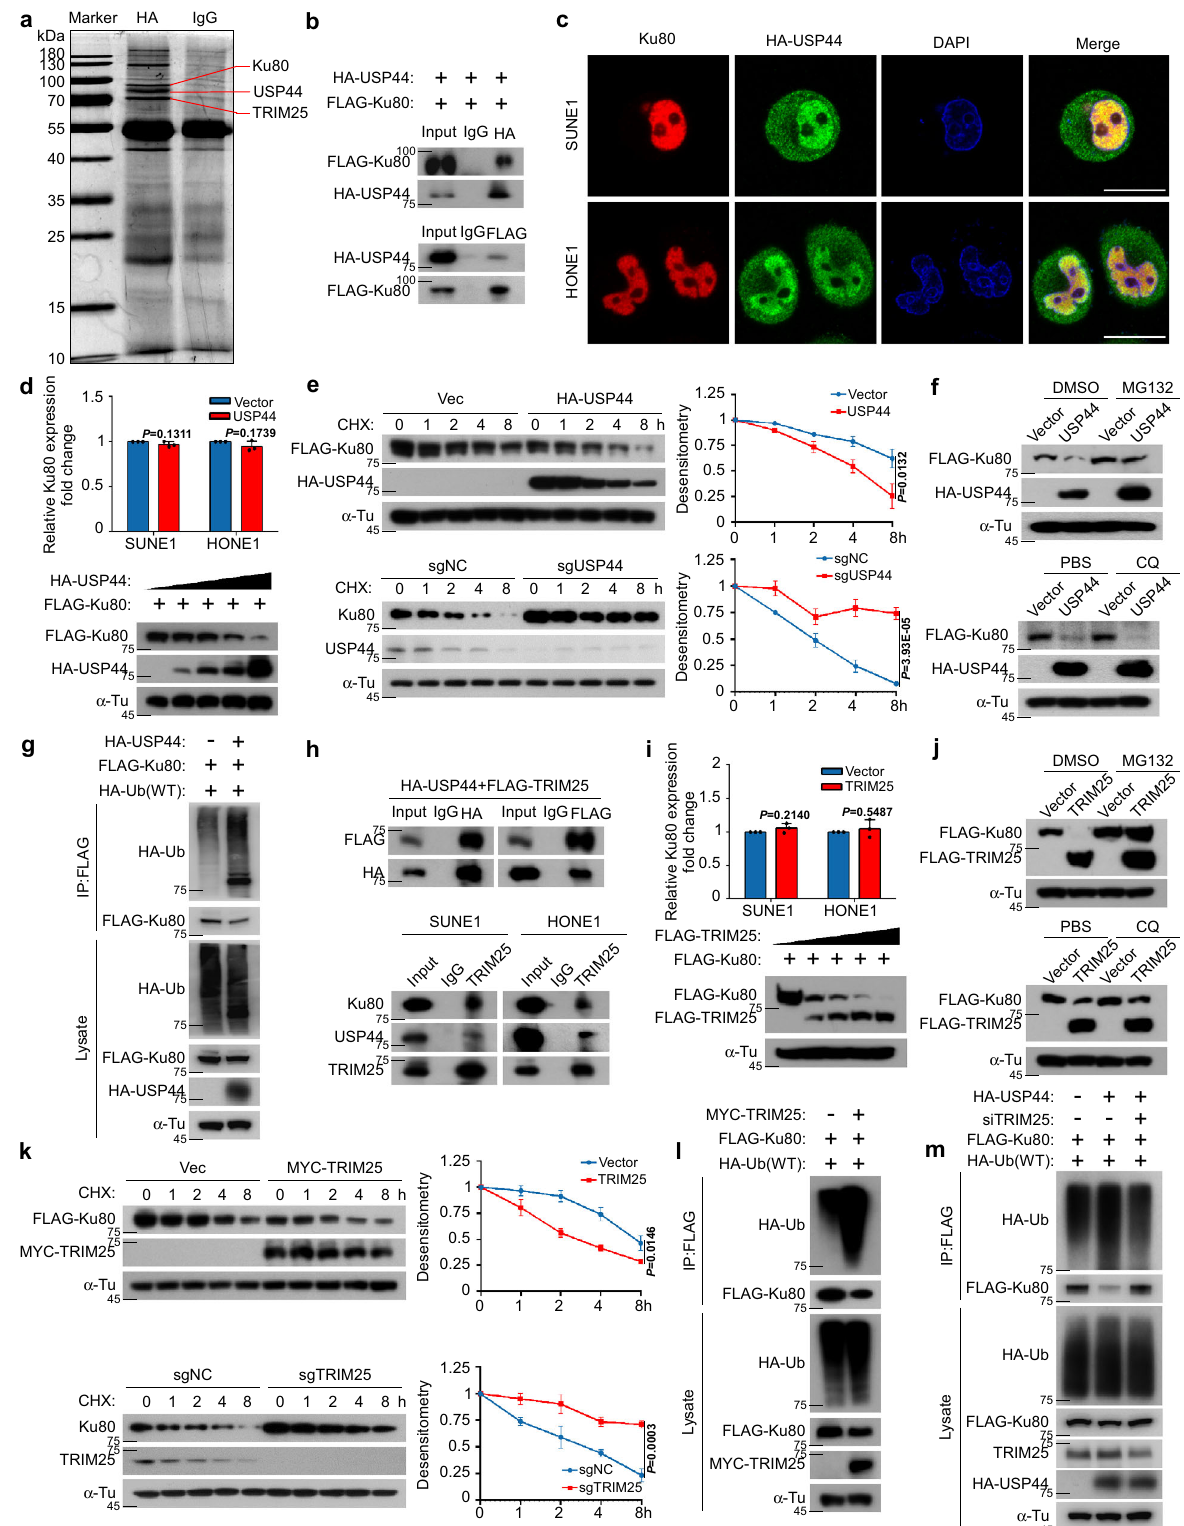
FLAG-Ku80:FLAG-TRIM25: FLAG-Ku80